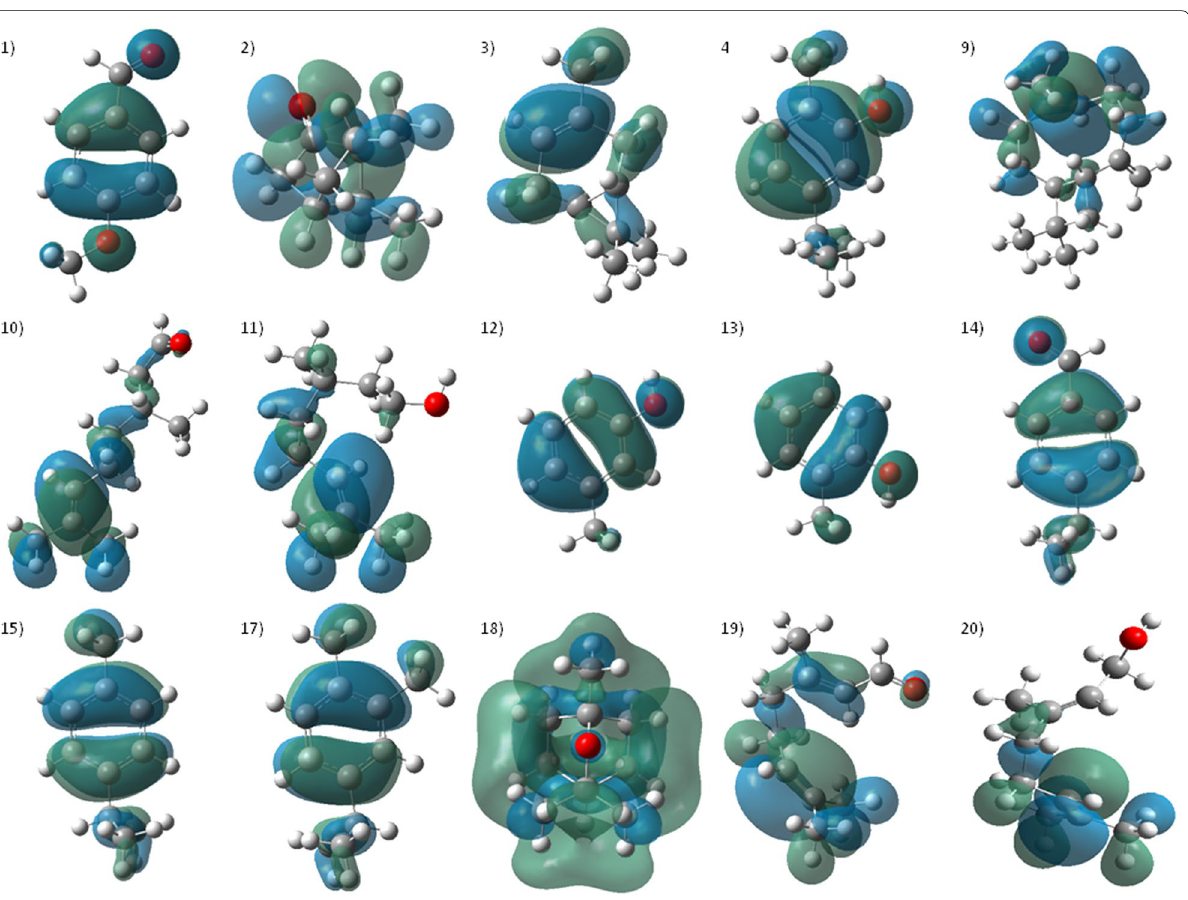
Fig. 4 The contour plots of LUMO orbitals of the most active molecules. (1) p ‑Anisaldehyde, (2) Canphor, (3) 3‑Carene, (4) Carvacrol, (9) β‑Caryophyllene, (10) Citronellal, (11) β‑Citronellol, (12) m‑Cresol, (13) o ‑Cresol, (14) Cuminaldehyde, (15) p ‑Cimene, (17) 3,4‑Dimethylcumene, (18) Eucalyptol, (19) Geranial, (20)